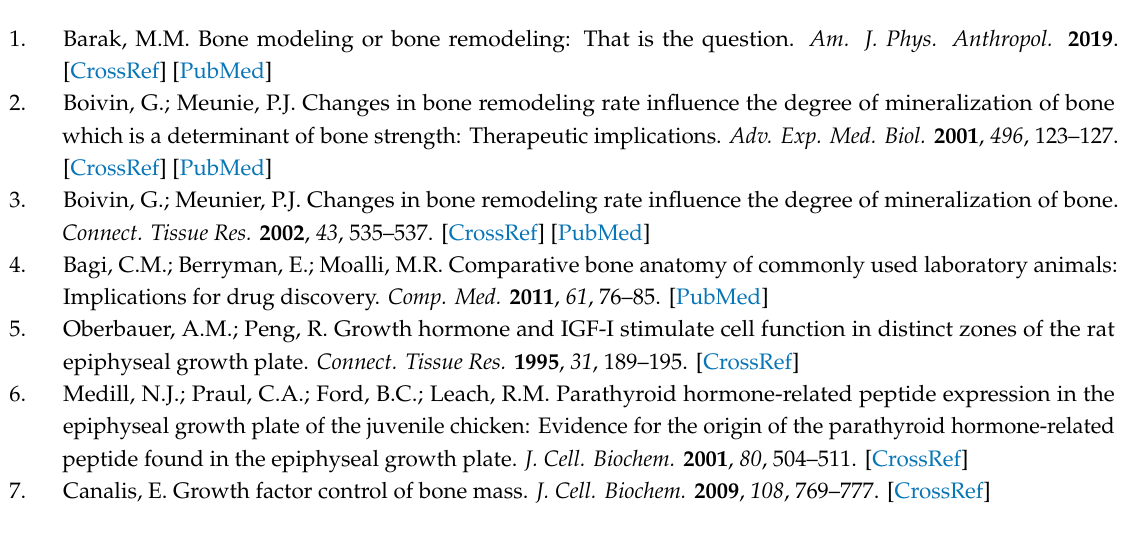
Figure S1: E ff ect of spirulina on kidney function, liver function, or blood glucose level; Figure S2: E ff ect of spirulina on blood lipid